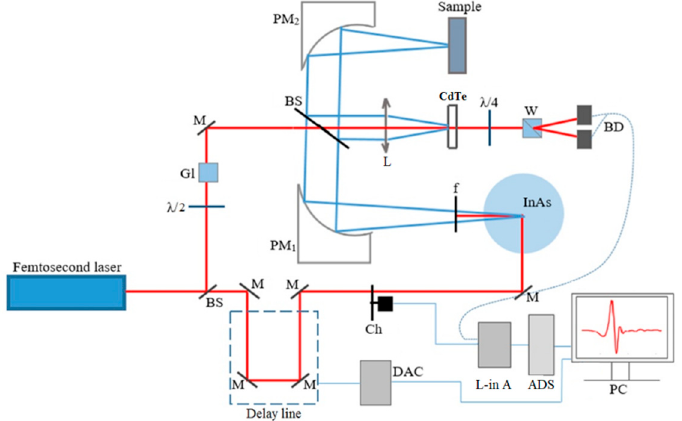
Figure 2. Schematic diagram of the THz TDS system in reflection mode. BS—beam splitter, M— mirror, Ch—chopper, PM—parabolic mirror, ADC—analog-to-digital converter, DAC—digital-to- analog converter, BD—balanced detector, L-in A—Lock-in Amplifier, W—Wollaston prism, f—filter, L—lens, λ /2—half-wave plate, and λ /4—quarter-wave plate.